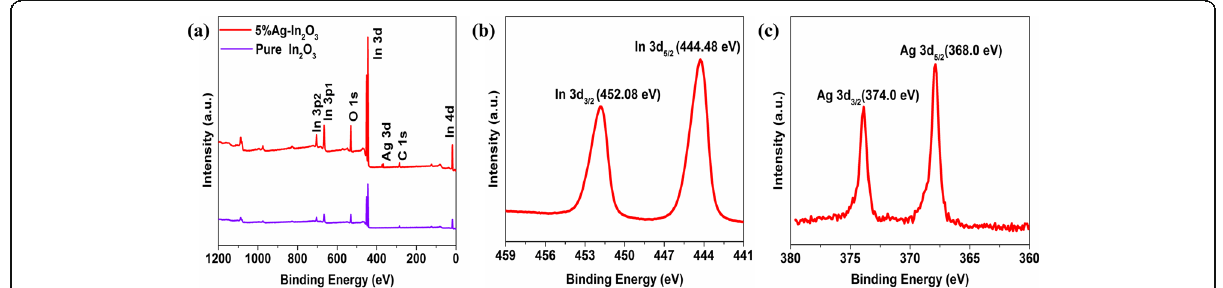
Fig. 3 a XPS spectrum of pure In 2 O 3 and 5%Ag-In 2 O 3 samples. b In 3d spectrum. c Ag 3d